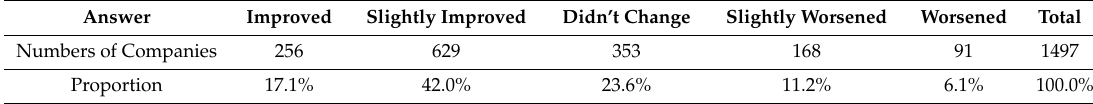
Table 3. Change in business performance after the first changes to loan conditions. 1